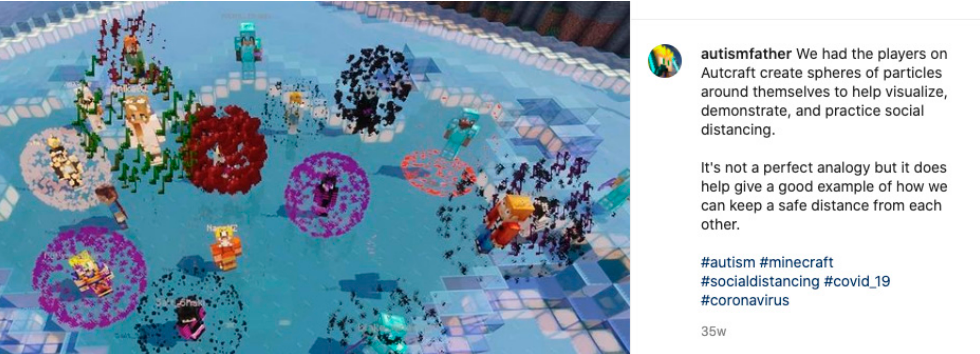
Figure 5. An Instagram post shared by the Autcraft server owner, “autism father” (avatar on the low left, surrounded by purple particles) who created spheres of particles with other Autcraft players to visualize social distancing.